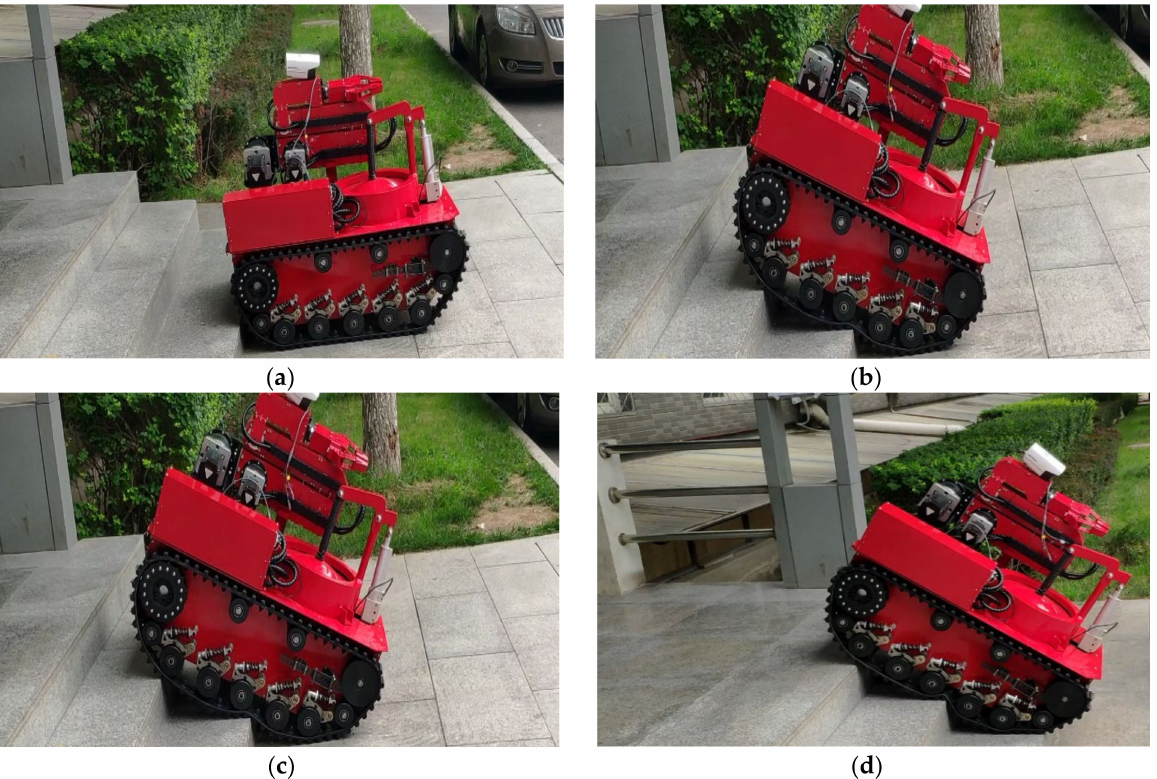
Figure 13. Obstacle crossing performance test of EOD robot: ( a ) Prepare for obstacle crossing; ( b ), ( c ) and ( d ) During EOD robot in obstacle